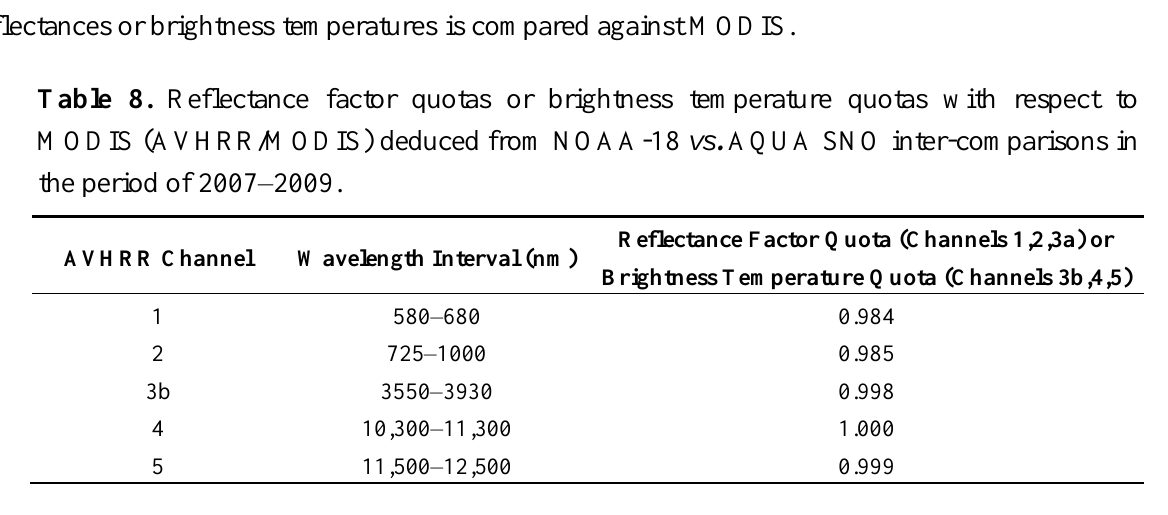
Table 9 Reflectance factor quotas or brightness temperature quotas for AATSR with respect to MODIS (AATSR/MODIS) deduced from SNO inter-comparisons in the period of 2007–2009.